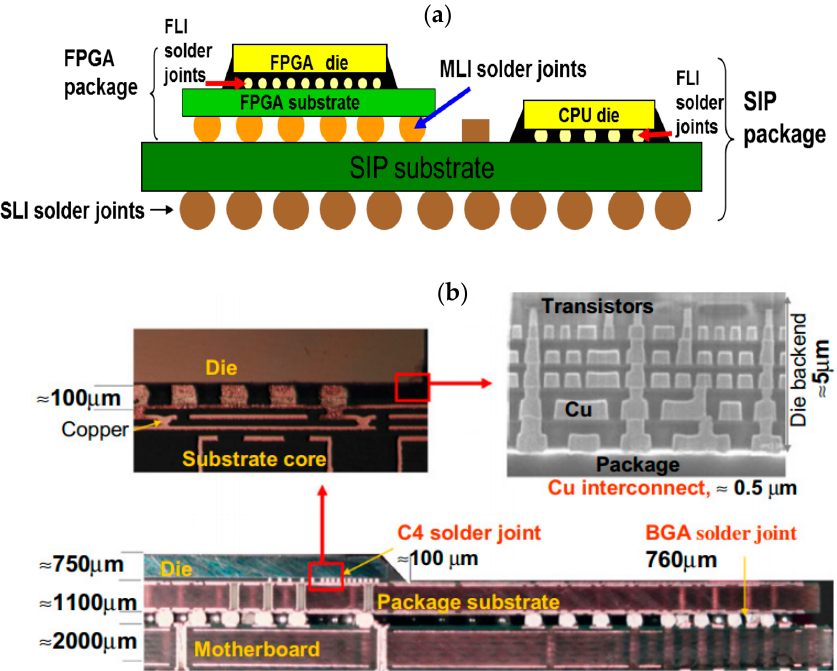
Figure 2. 3D packages with multi-layer components ( a ) SIP package with POP configuration [25] and ( b ) Cross sections of a 3D package with stacked die and TSV configuration. Approximate dimensions and zoomed parts which marked with squares [26].